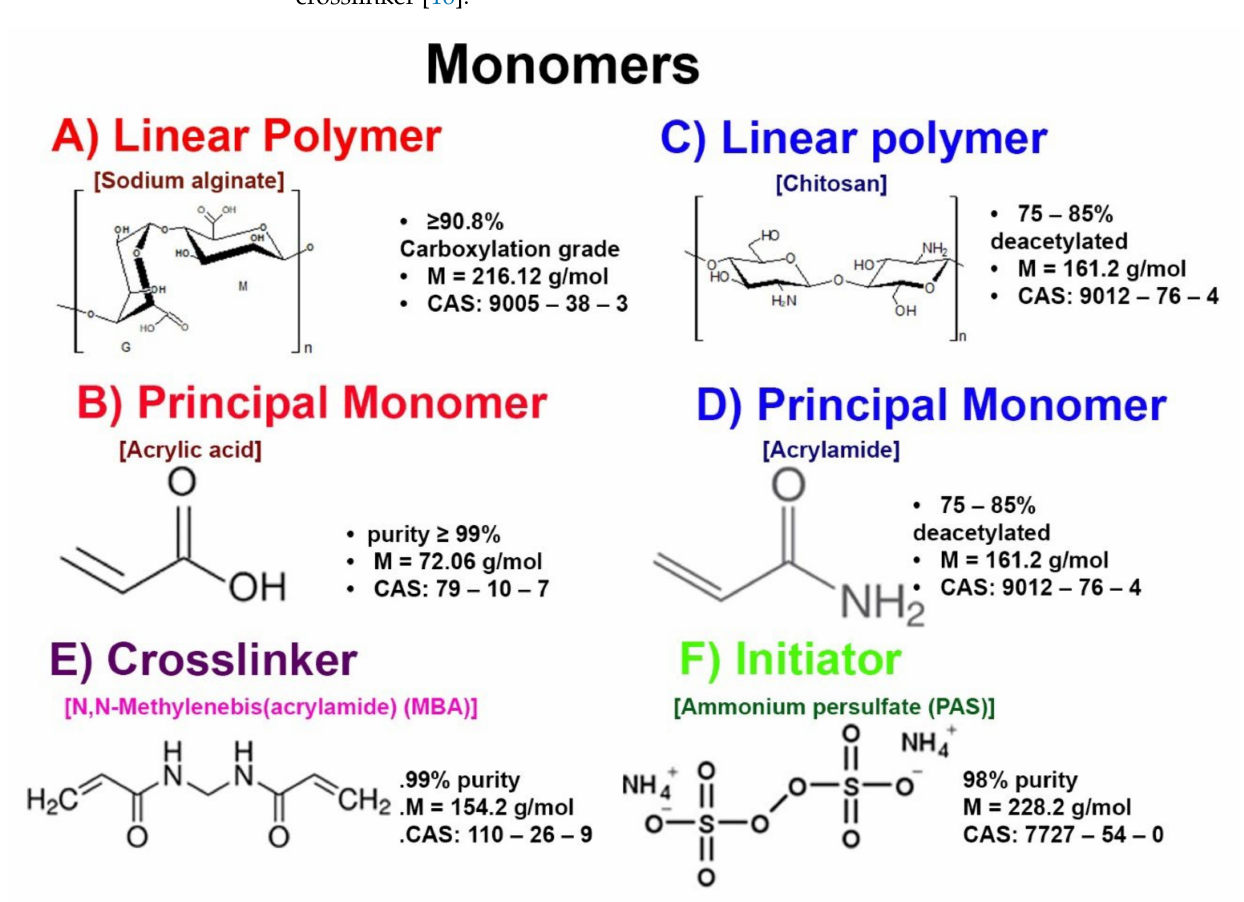
Figure 1. Structures of the monomers and their